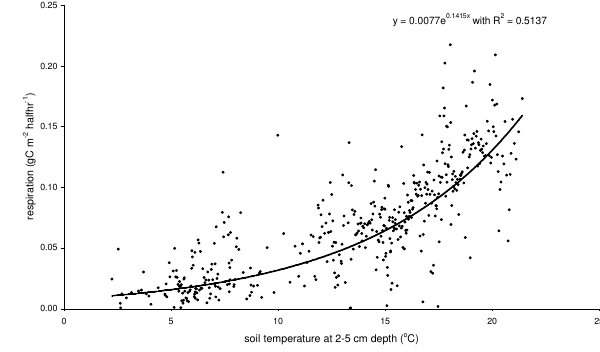
Fig. 6. Relation between soil temperature and respiration using noc- turnal CO 2 fluxes with the exponential best fit line and its regression equation. Figure 7: Measured CH 4 fluxes at the Horstermeer site over the period 2004 to 2006 for the relatively dry land (above) and over 2006 for the saturated land and the ditches (below).